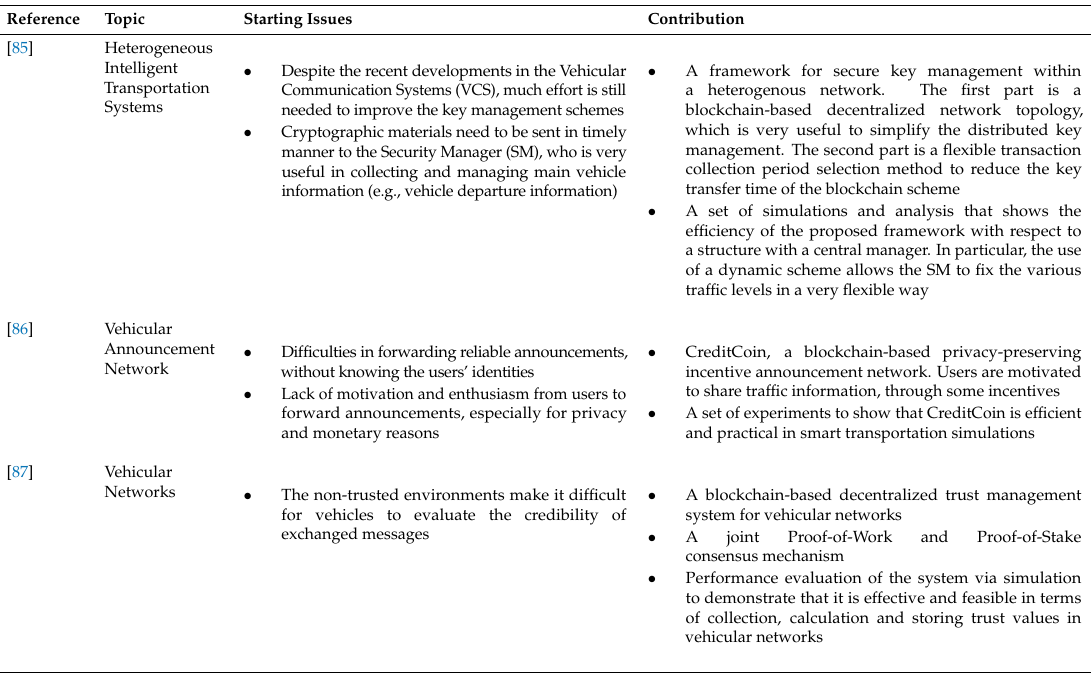
Table 9. Analysis of the most relevant documents belonging to C 2 (part 2/3).